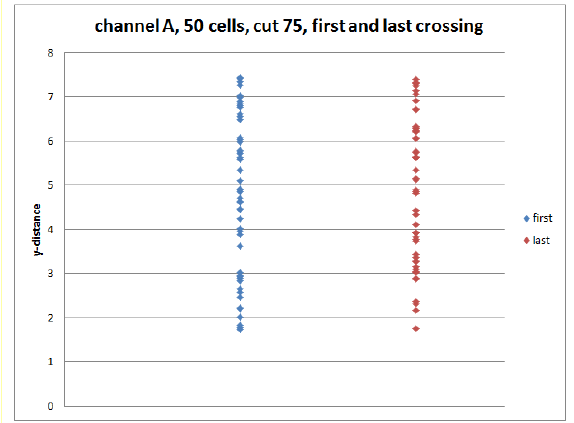
Fig. 9. For 50 cell in channel A and cutting position 75 + k.100 μm the distributions of distances for first and last crossing are much more similar but not visible without statistical